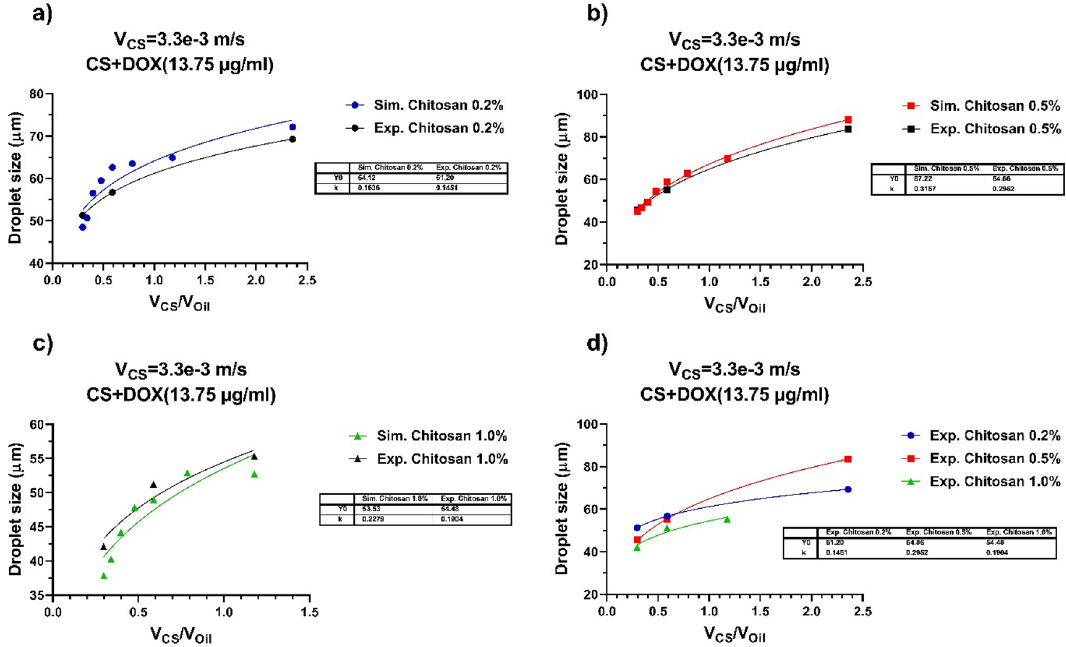
Figure 8. Comparisons the size of droplets generated using the computer simulator and experimental experiments. ( a ) CS 0.2%, ( b ) CS 0.5%, ( c ) CS 1.0%, ( d ) comparison of experimental data of droplet production for three concentrations of CS + DOX at the fixed velocity of the dispersed phase (3.3 mm/s), and velocity ratios of 2.36, 0.59 and 0.27, respectively. DOX concentration is 13.75